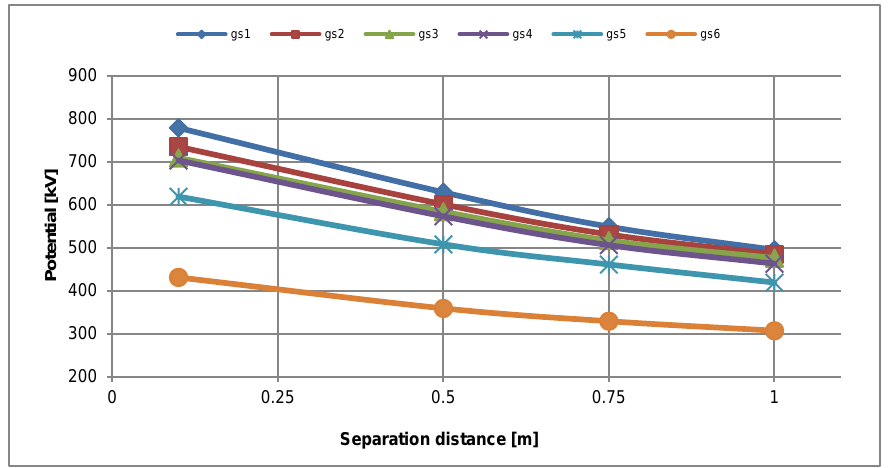
Figure 10. Maximum potential for soil structure D and grounding systems of Table 2.